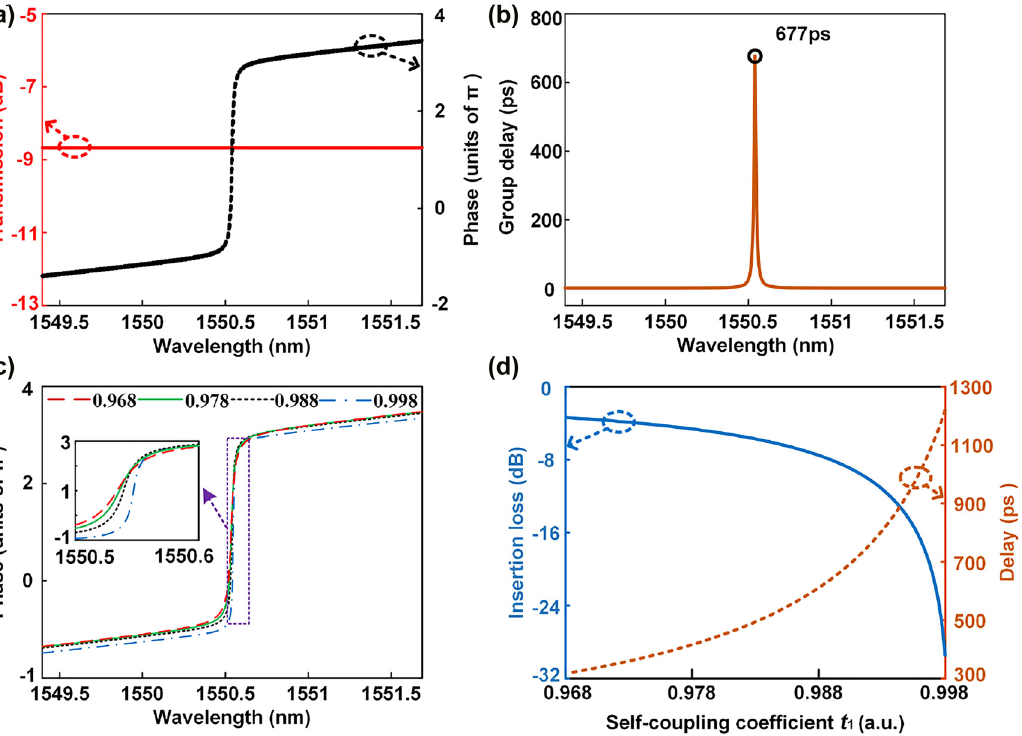
Figure 2: Simulation results of the second-order APF. = 0.99. (b) Corresponding group delay of (a) Amplitude (red solid curve) and phase (black short dashed curve) frequency responses when t 1 is set as 0.968 (red dashed curve), 0.978 (green solid curve), 0.988 (black short dashed the second-order APF. (c) Phase responses when t 1 curve) and 0.998 (blue dashed-dotted curve). (d) Variations in the insertion loss (blue solid curve) and delay (red short dashed curve) of the is changed from 0.968 to second-order APF when t 1